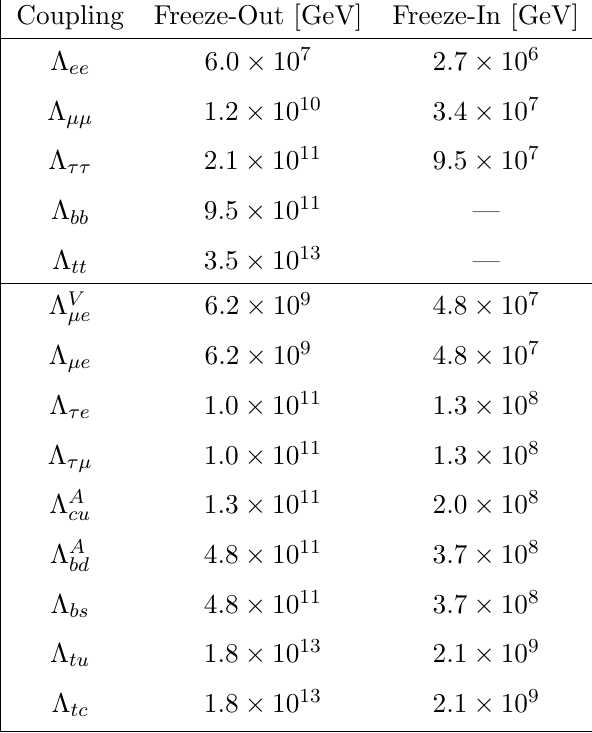
Table 1 . Constraints on couplings to matter where freeze-out assumes T R assume T R > m f . This table is adapted from